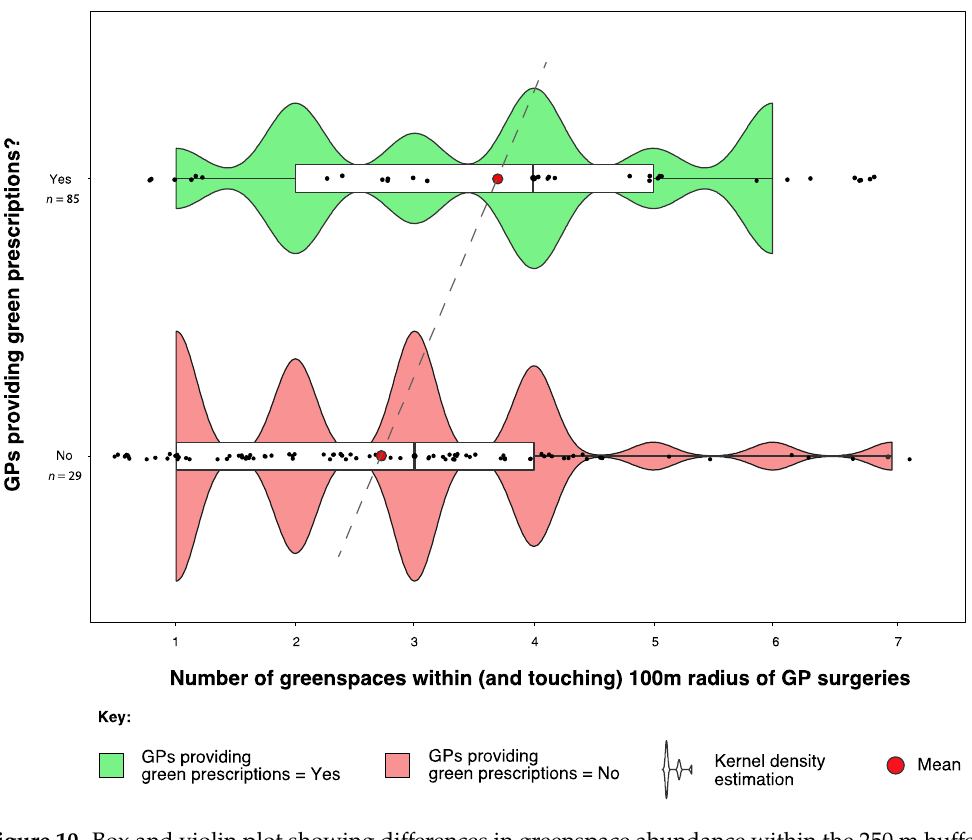
Figure 10. Box and violin plot showing differences in greenspace abundance within the 250 m buffer zone around GP surgeries that did (green) and did not (red) prescribe nature-based interventions. Initial indications suggested that greenspace abundance was higher for the remaining Table 2. Greenspace abundance for all buffer radii between 100 m and 5 km (50 m excluded due to data deficiency) around GP surgeries.